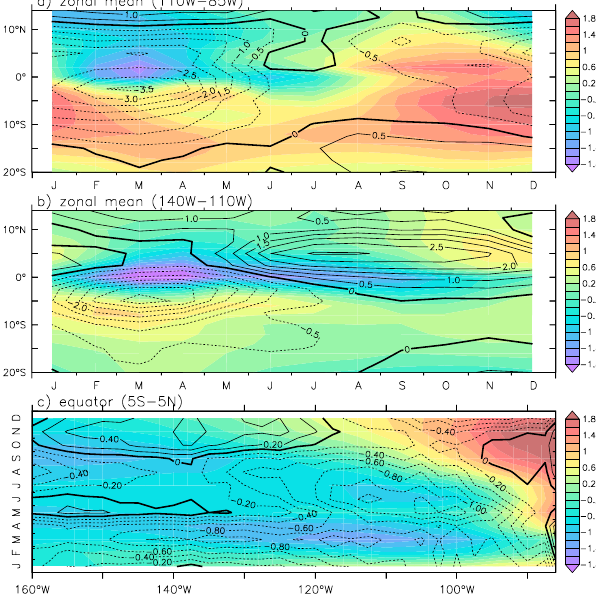
Figure 4. Evaluations of MME SST biases (shadings), surface Figure 4 Evaluations of MME SST biases (shadings), surface northward wind biases 3 northward wind biases (contours in a and b ), and eastward wind biases (contours in c (contours in (a) and (b)), and eastward wind biases (contours in (c)). 4